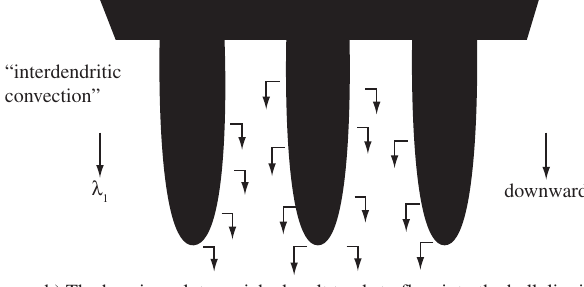
Figure 3. Schematic representation of solute flow between primary dendritic arms growing, a) upwards; and b)